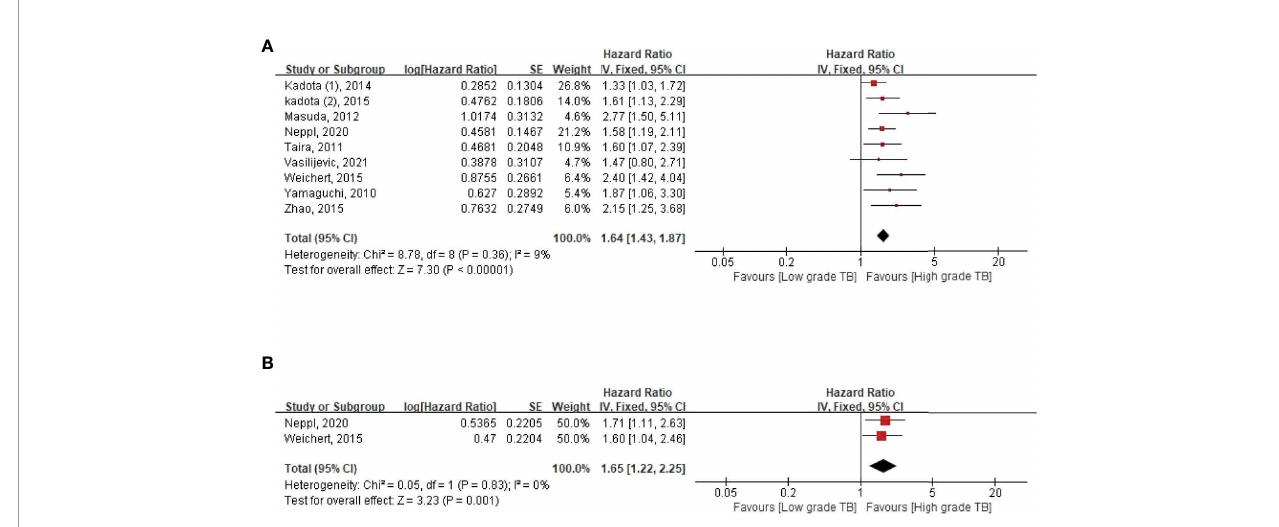
FIGURE 1 | Pooled hazard ratios for (A) overall survival and (B) disease-free survival according to the tumor budding expression.